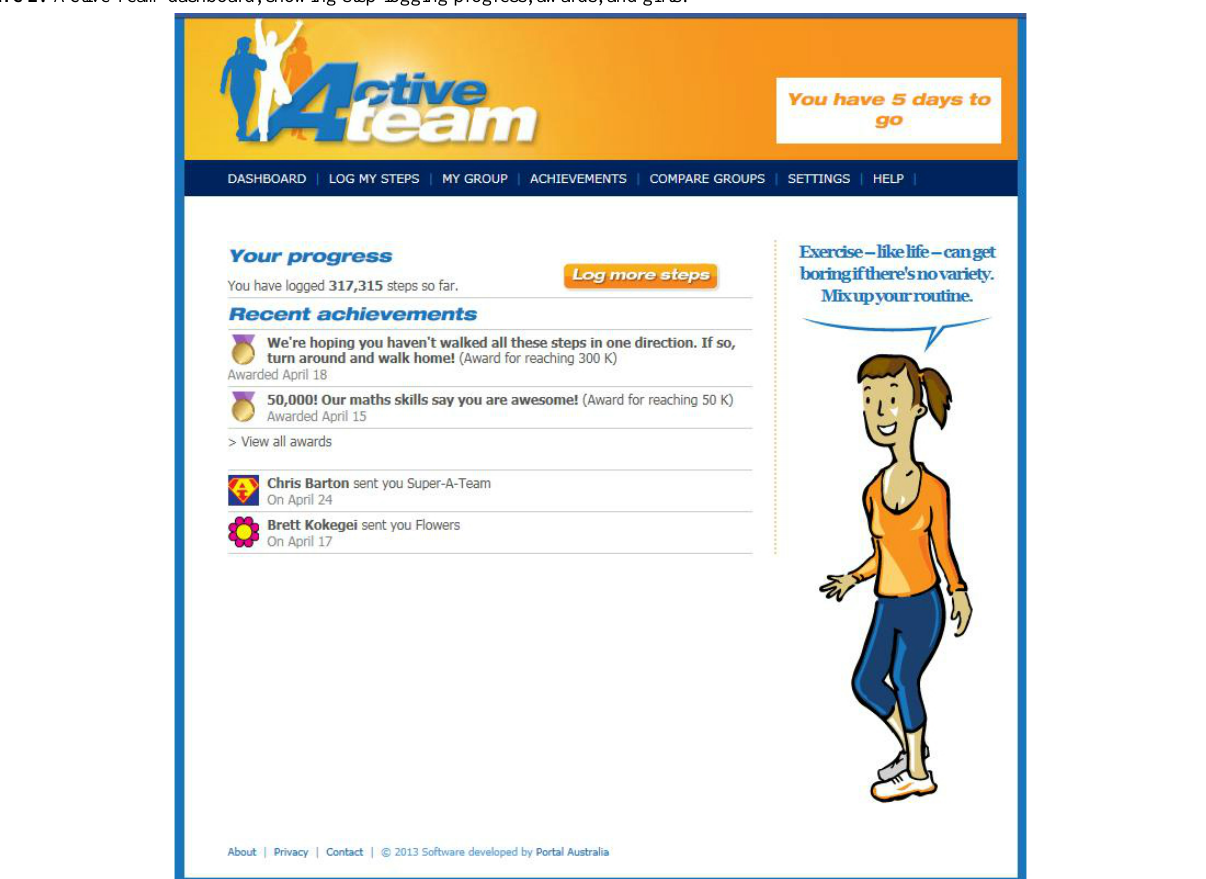
Figure 2. Active Team dashboard, showing step-logging progress, awards, and